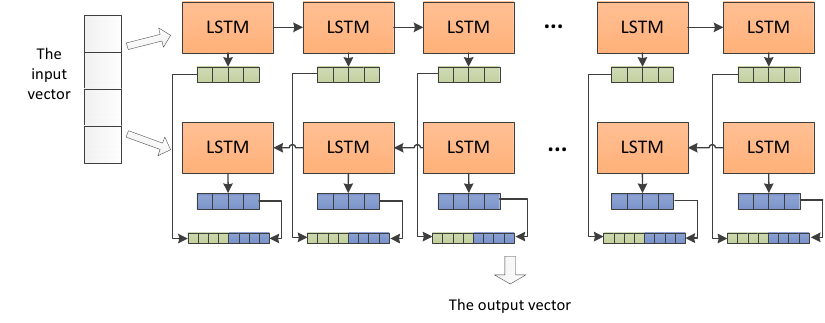
Figure 4. Structure of the LSTM unit .